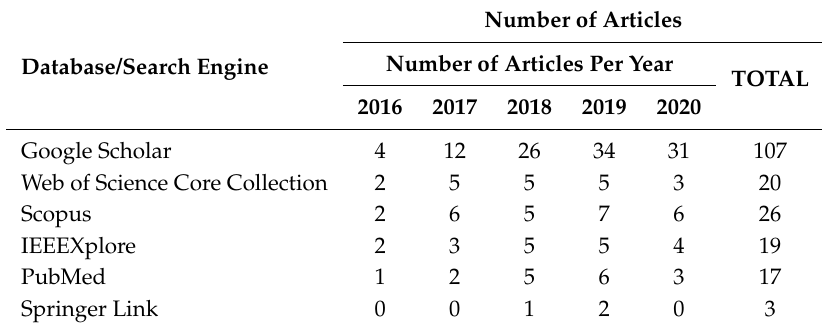
Table 1. Number of works on gyrocardiography per year in various sources on 1 October